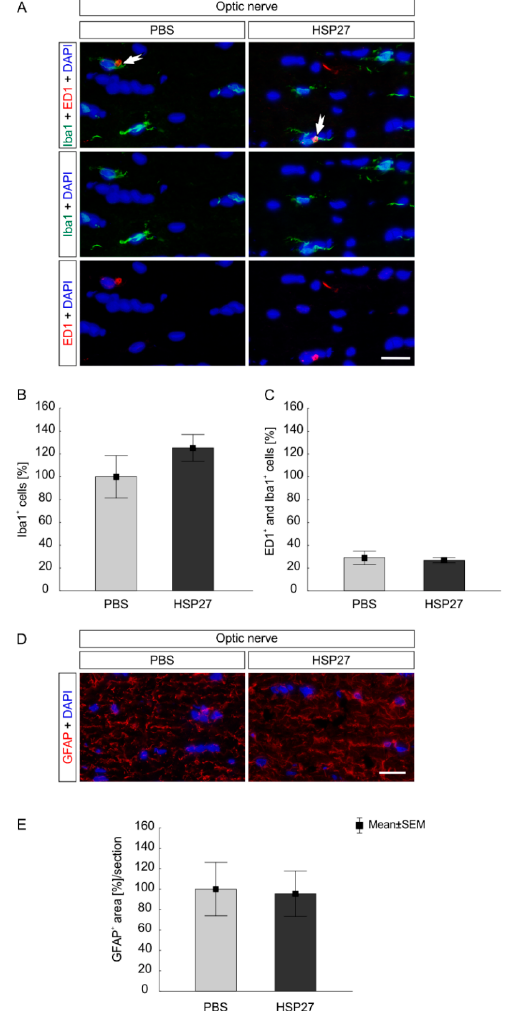
Figure 8. Optic nerve demonstrated no glia cell response after HSP27 injection. ( A ) Iba1 (green), ED1 (red), and DAPI (blue) were stained in optic nerves to evaluate microglia/macrophages and activated ones (arrows). ( B ) The number of Iba1 + microglia/macrophages was similar in the HSP27 and the PBS group ( p = 0.27). ( C ) The same was noted for the number of activated microglia /macrophages (ED1 + and Iba1 + ). No differences could be observed between both groups ( p = 0.73). ( D ) Macroglia (GFAP, red) and cell nuclei (DAPI, blue) were stained in the optic nerve. ( E ) Additionally, there was no difference in GFAP + area between the HSP27 group and the PBS group ( p = 0.9). Scale bar = 20 μ m, n = 6/group.